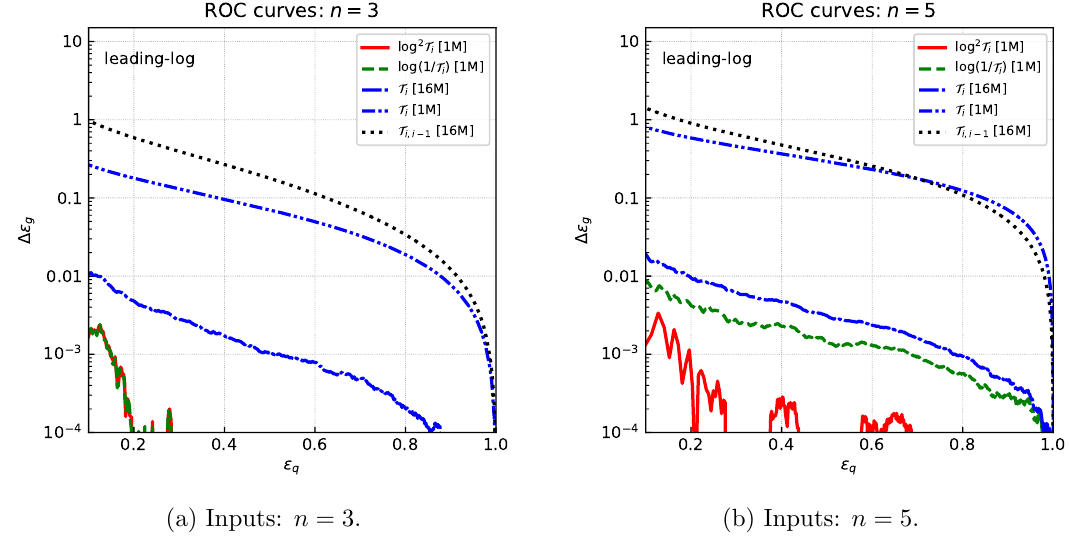
Figure 5 . ROC curves obtained from a trained perceptron with di(cid:11)erent inputs. Note that, in order to highlight deviations from optimal performance, we show eq. (4.1). Thus, the closer these curves are to zero, the better the